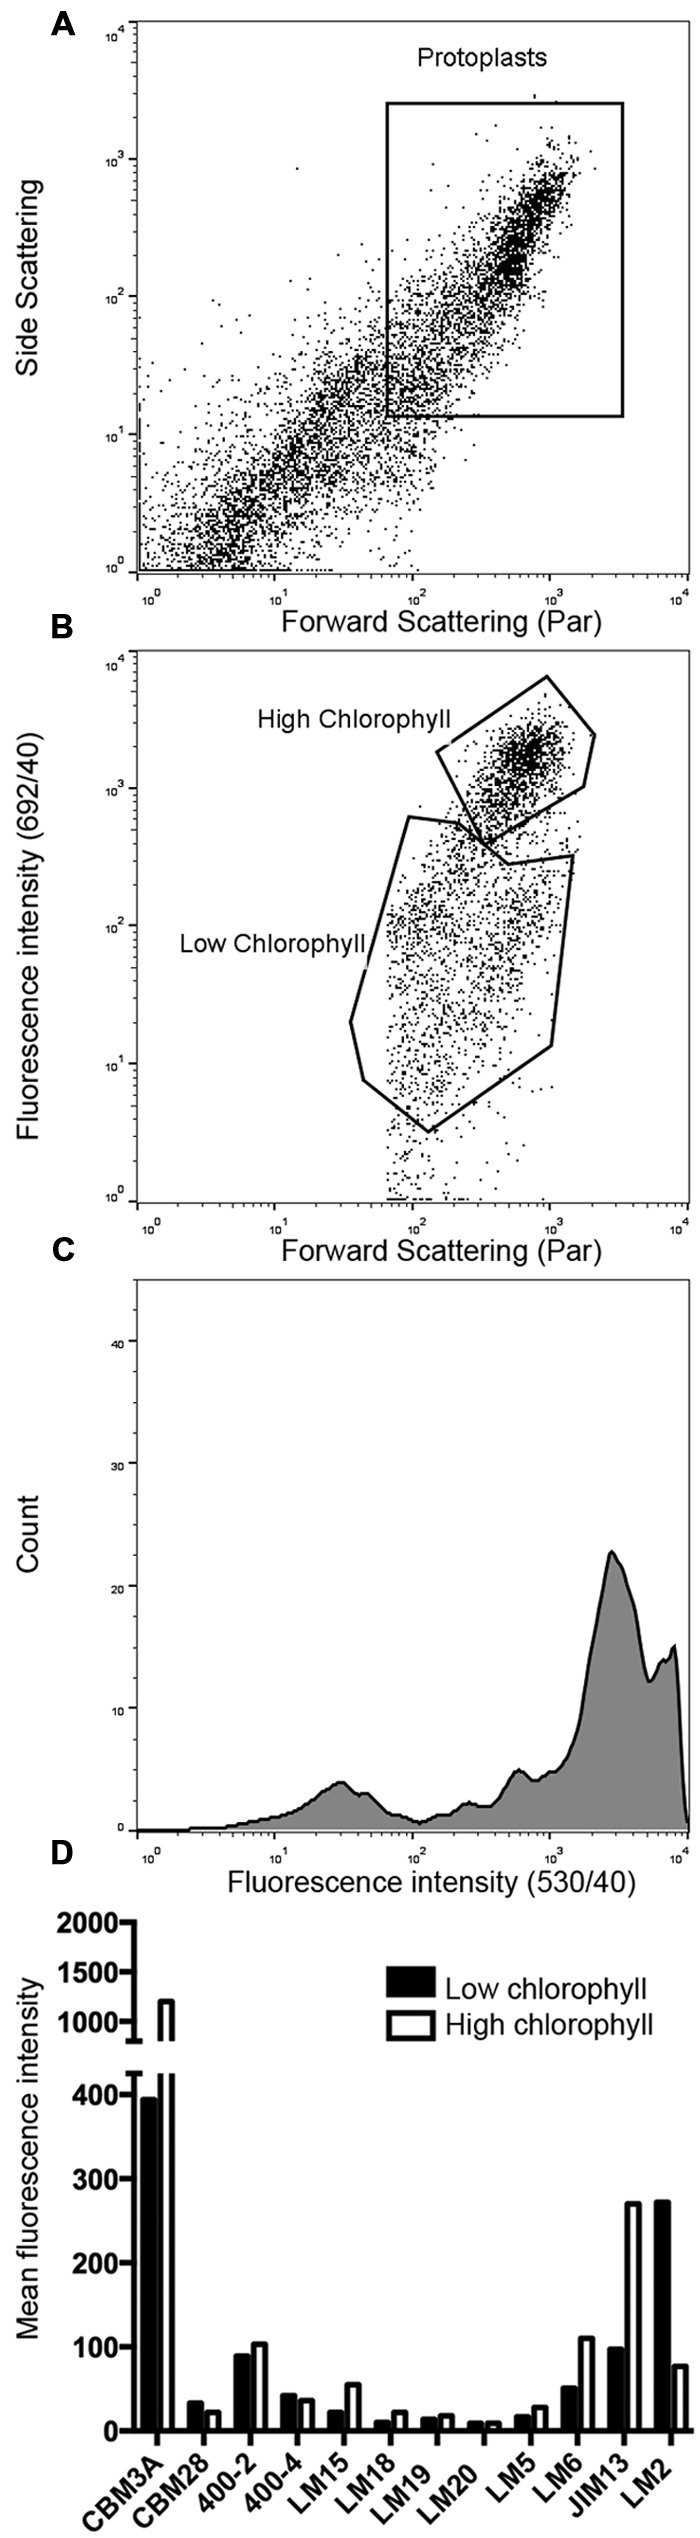
Flow cytometry analysis of P. patens protoplasts regenerated for 24 h and labeled with CBM or antibodies. (A) Scatter plot of protoplasts labeled with CBM3a and gated for roundness based on forward scatter (FSC) and side scatter (SSC). (B) Round protoplasts (population 1 above) gated for high and low chlorophyll autofluorescence. (C) Histogram of fluorescence intensities of population 1 showing peaks for subpopulations with high and low chlorophyll autofluorescence. (D) Mean fluorescence intensities (530/40) of regenerated protoplasts gated for roundness based on FSC and SSC and then for low vs. high chlorophyll autofluorescence. Differences in fluorescence intensity between high and low chlorophyll populations were significant (p = < 0.003) for all probes except LM18, LM19, and LM20, which were not significantly greater than the negative control.